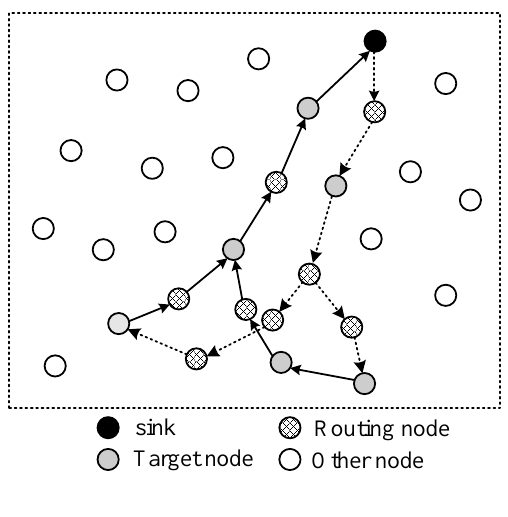
Figure 6. Multi-ring